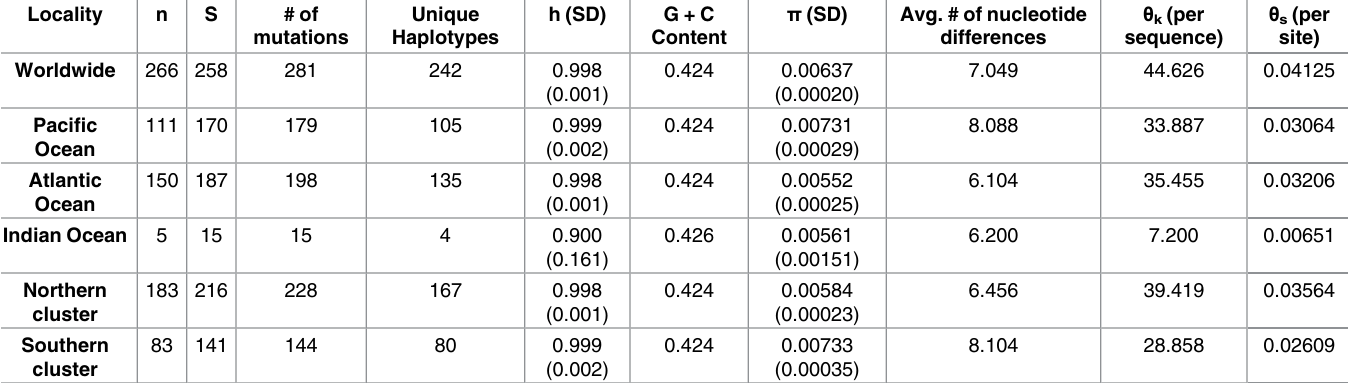
Table 1. Summary statistics from population genetic analyses of Exocoetus volitans divided by ocean basin, and population clusters (northern and southern), and overall. S = number of variable sites; h = haplotypediversity; π = nucleotidediversity. Locality